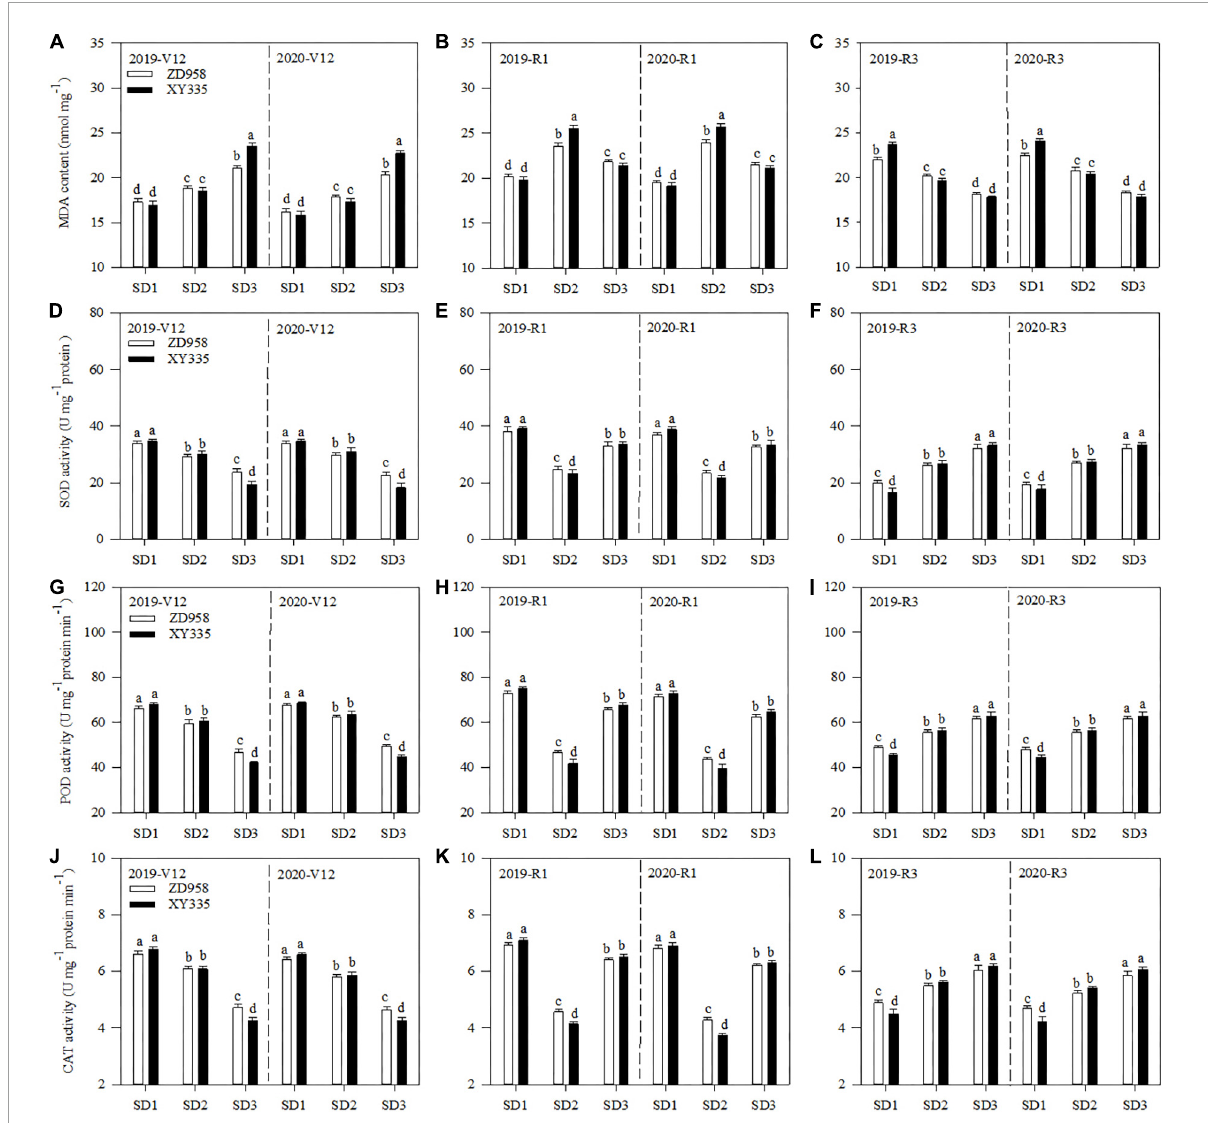
FIGURE1 MDA content (A–C) and activities of SOD (D–F) , POD (G–I) , and CAT (J–L) of maize ear leaf at V12, R1, and R3 stages under different sowing dates in 2019 and 2020. SD1, early sowing; SD2, conventional sowing; SD3, delay sowing; POD, peroxidase; CAT, catalase; MDA, malondialdehyde; V12, 12-leaf stage; R1, silking stage; R3, milking stage. Different letters above the error bars indicate significant difference at the 0.05 probability level.